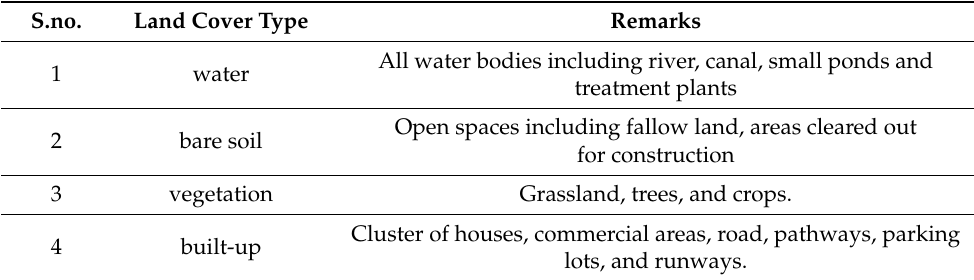
Table 3. Land cover classification scheme used in random forest Classifier. S.no.